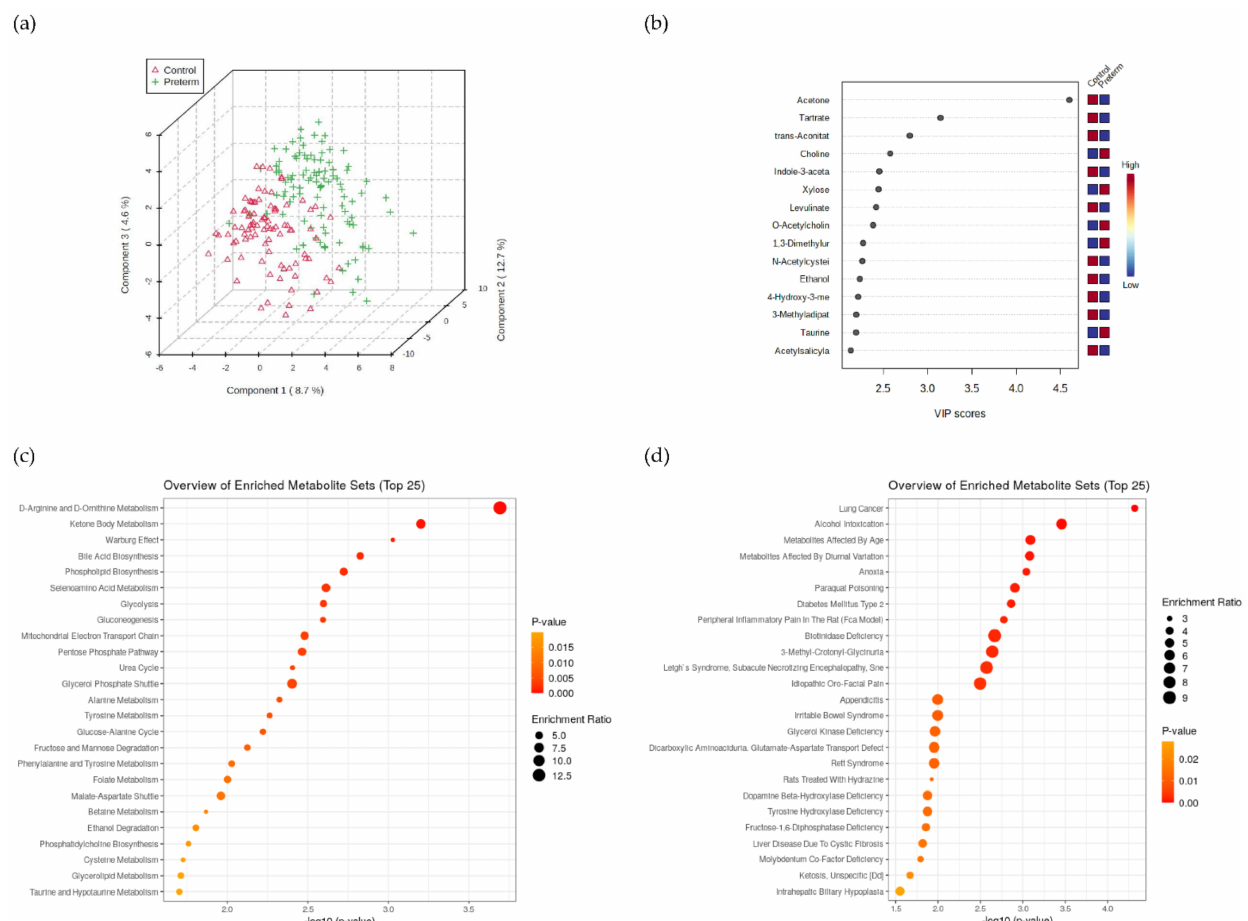
Figure 2. ( a ) Urine metabolomes comparing preterm and full-term born adults and the most differ- entiating metabolites based on PLSDA method ( b ). The most enriched pathways associated with metabolism ( c ) and diseases ( d ) based on urinary metabolomes. Enlarged ( c , d ) figures were added to supplementary (Figures S5 and